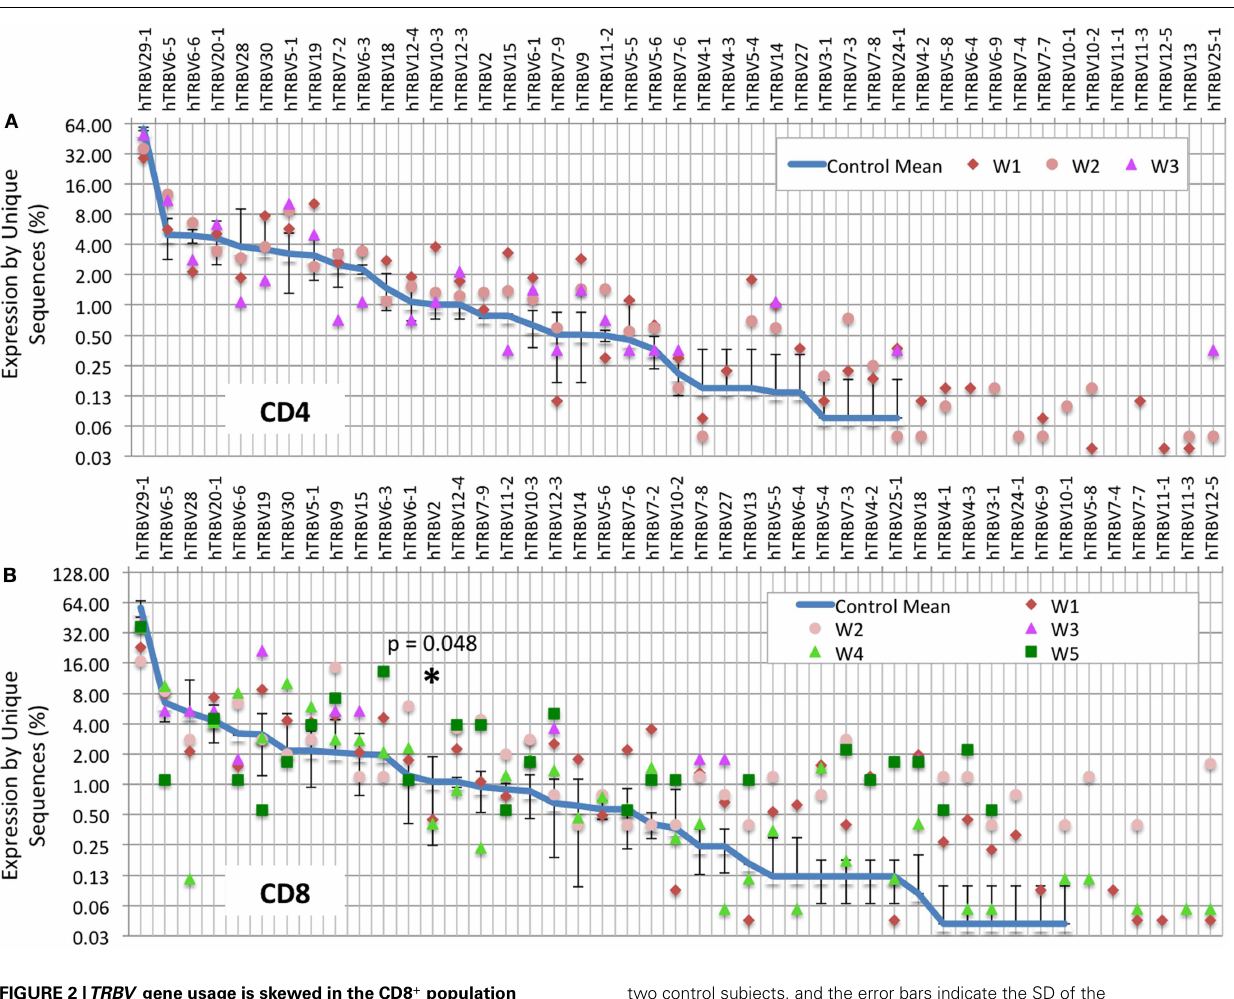
FIGURE 2 | TRBV gene usage is skewed in the CD8 + population ofWAS patients .The frequency of usage of individual TRBV genes among unique TRB sequences is displayed for the CD4 + (A) or CD8 + (B) cells.The blue line indicates the average frequency of the